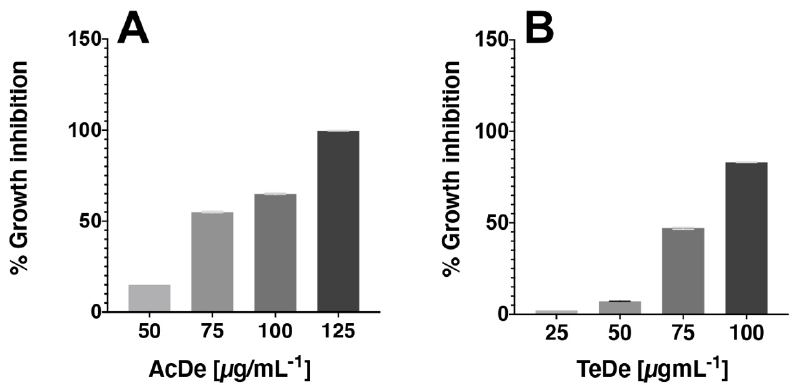
Figure 2. Representative WST-1 assay showing the cytotoxicity activity of AcDe ( A ) and TeDe ( B ) in 4T1 type of cancer cell after 24 h of incubation in vitro.